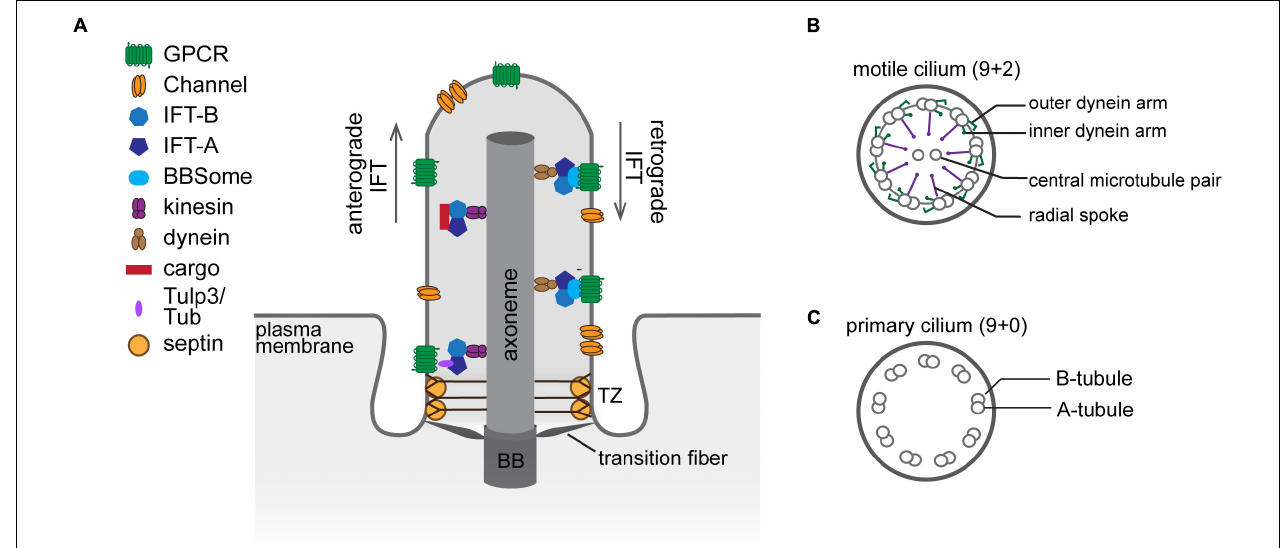
FIGURE 1 | The structural organization of the cilium. (A) Diagram of a cilium depicting major structural components and ciliary sub-compartments. (B,C) Cross-section schematics of a typical motile (B) and primary (C) cilium. BB, basal body; TZ, transition